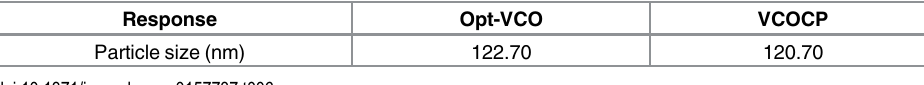
Table 6. Response value for Opt-VCO and VCOCP.